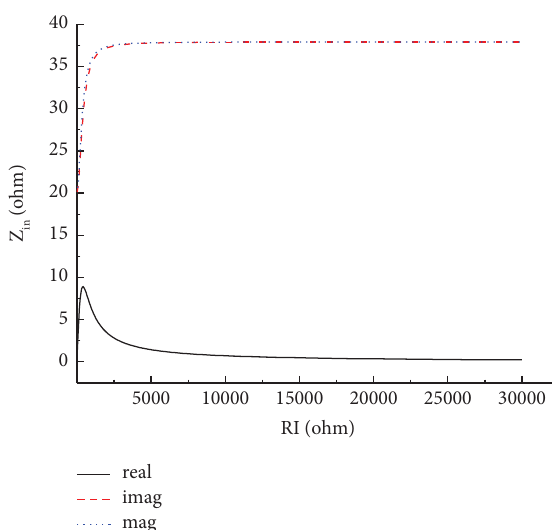
Figure 28: Te input impedance of the improved circuit shown in Figure 27.